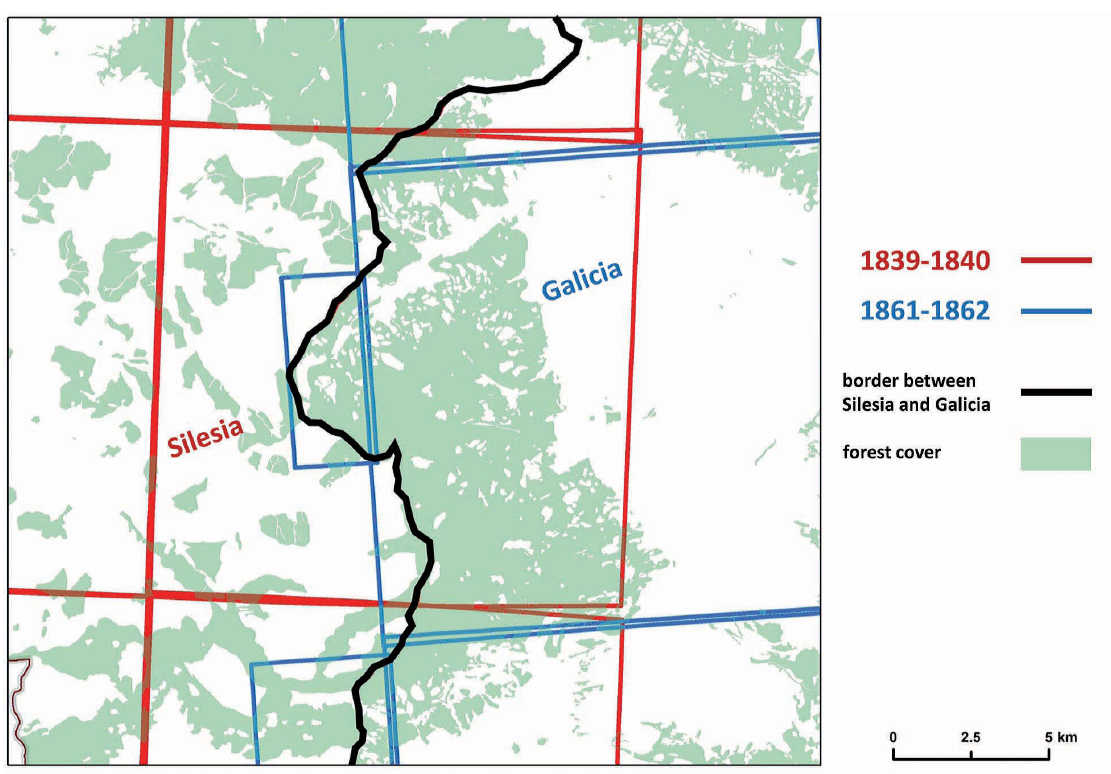
Fig. 4. Differences in forest cover between Silesia and Galicia shown on different editions of the Second Military Survey